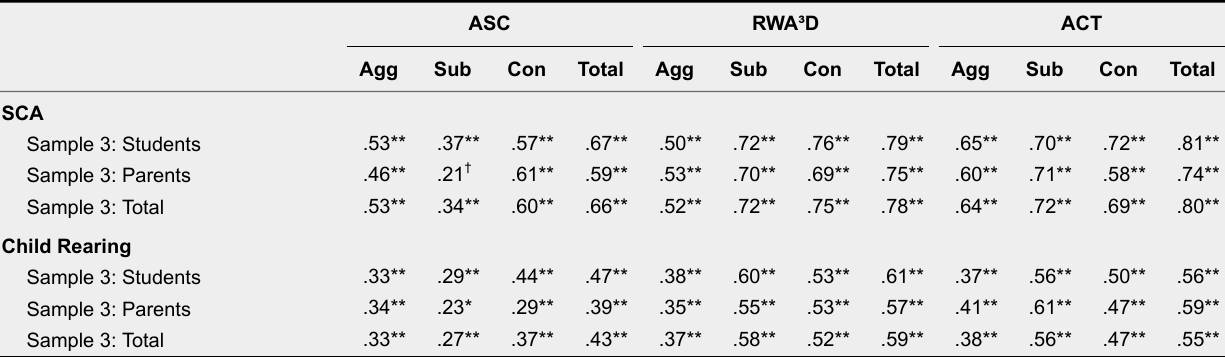
Correlations Between Unidimensional Measures and all Three of the Three Factor Authoritarianism Scales